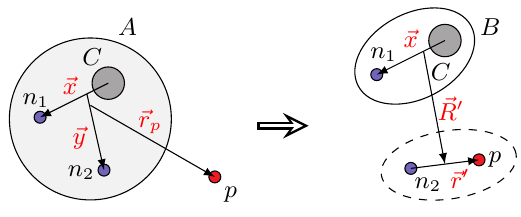
Figure 1. Schematic representation of the ( p , pn ) process in- duced by a two-neutron halo